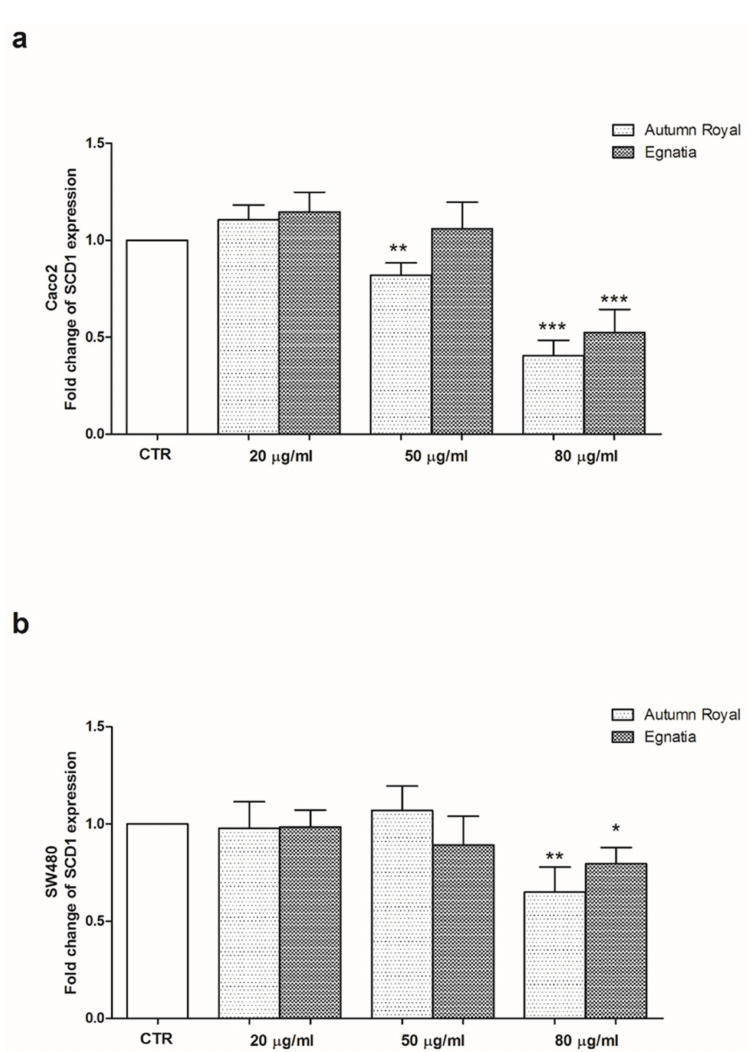
Figure 2. ( a ) SCD1 gene expression levels detected in Caco2 cells treated with increasing concentrations of Autumn Royal and Egnatia GSEs (20, 50, 80 µ g / mL) for 48 h of incubation; ( b ) SCD1 gene expression levels detected in SW480 cells treated with increasing concentrations of Autumn Royal and Egnatia GSEs (20, 50, 80 µ g / mL) for 48 h of incubation. All data are expressed as mean ± Standard Deviation (SD) of three consecutive experiments. p -value was determined by ANOVA with Dunnett’s post-test. * p < 0.05, ** p < 0.03 and *** p < 0.01 versus the control group